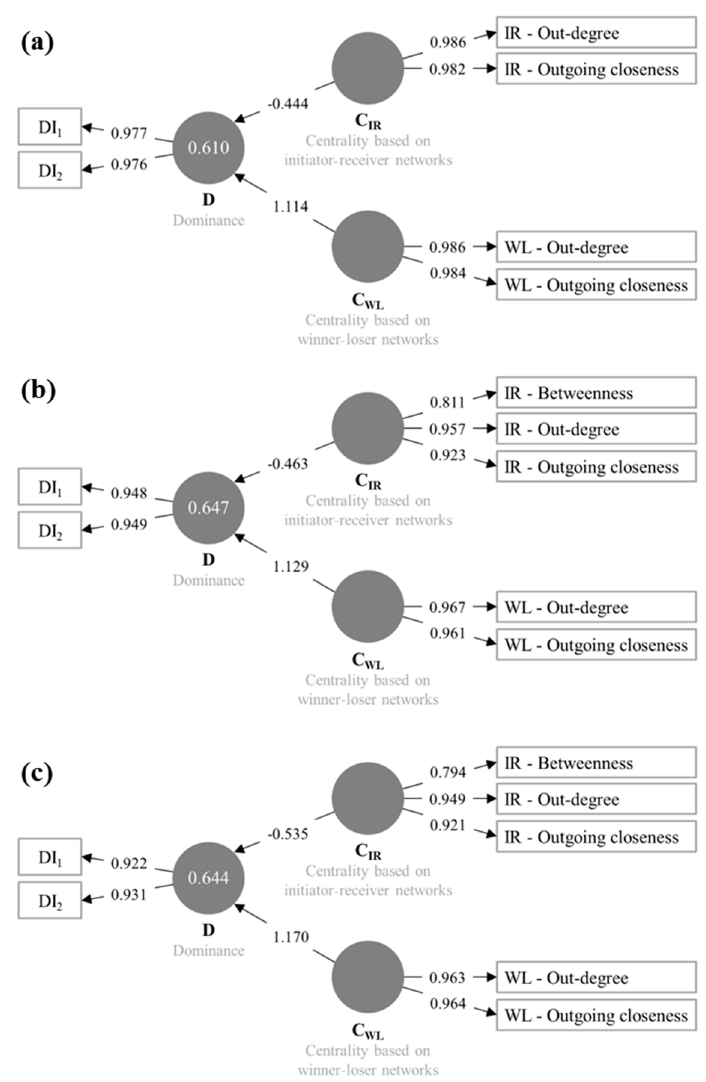
Figure 6. Calculated partial least squares structural equation modelling (PLS-SEM) for the relationship between dominance and centrality for the three age groups (( a ) weaned piglets, ( b ) fattening pigs, ( c ) gilts). Circles represent latent variables; rectangles represent measurement variables. Arrows between circles represent relationships between latent variables (path coefficients). Arrows between circles and rectangles represent indicator reliabilities (of the respective measurement variables). Numbers in circles represent the coefficient of determination (which is only calculated in case of endogenous variables). IR indicates the centrality parameters calculated for the initiator-receiver networks. WL indicates the centrality parameters calculated for the winner-loser networks.